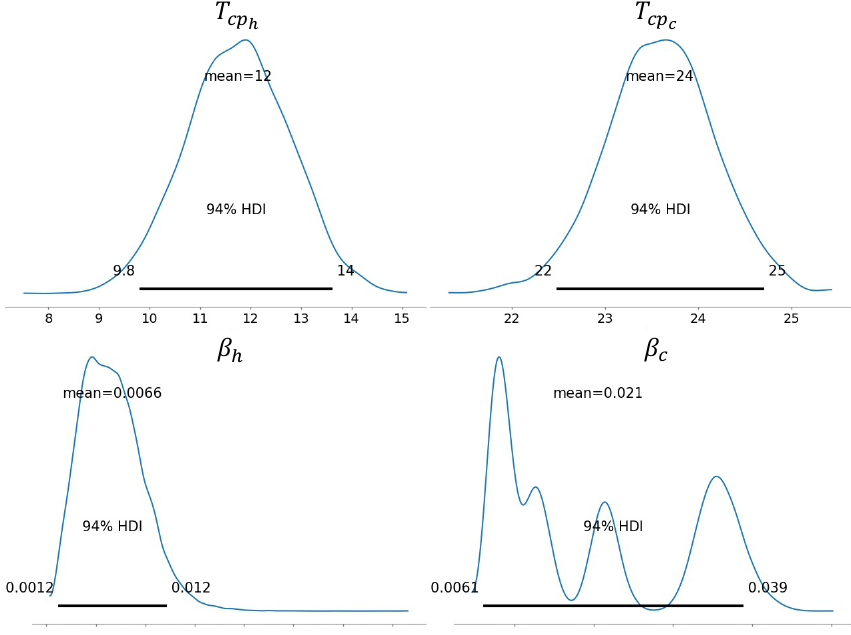
Figure 16. Posterior distributions estimated for the heating and cooling change-point temperatures (upper panels) and for the heating and cooling linear dependence coefficients (lower panels) in Rat_education_Royal